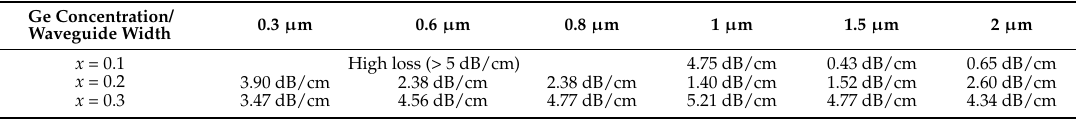
Table 3. Linear loss figures for Si 1 − x Ge x waveguides with varying widths and Ge concentration ( x ) [55]. Ge Concentration/ Waveguide